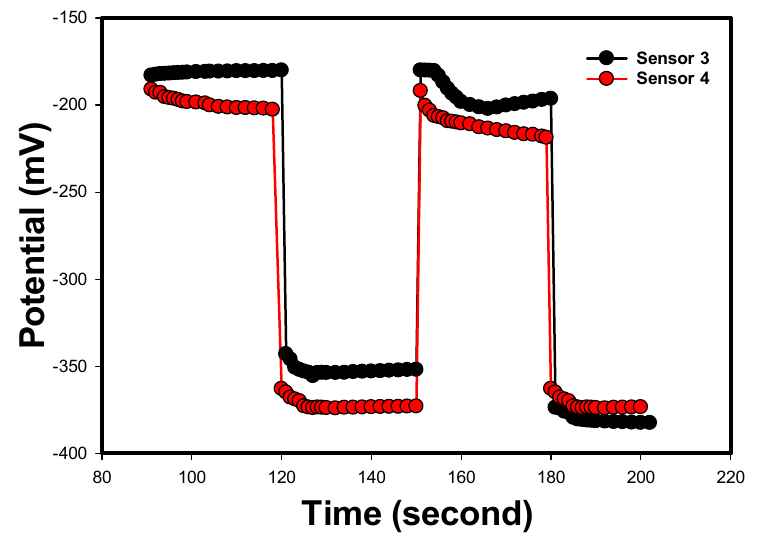
Figure 7. Water-layer tests of sensors 4 and 5 were measured in Tris buffer using solutions of 10 − 3 M 2,4-D and 10 − 3 M NaCl at 25 °C.